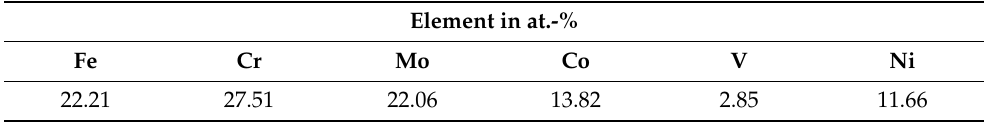
Table 3. Chemical composition of the used HEA in advance of casting (EDX). Element in at.-%